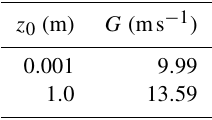
Table 5. Calibrated geostrophic wind speeds ( G ) and corresponding roughness length ( z 0 ), which yield a wind speed of 8ms − 1 at a hub height of